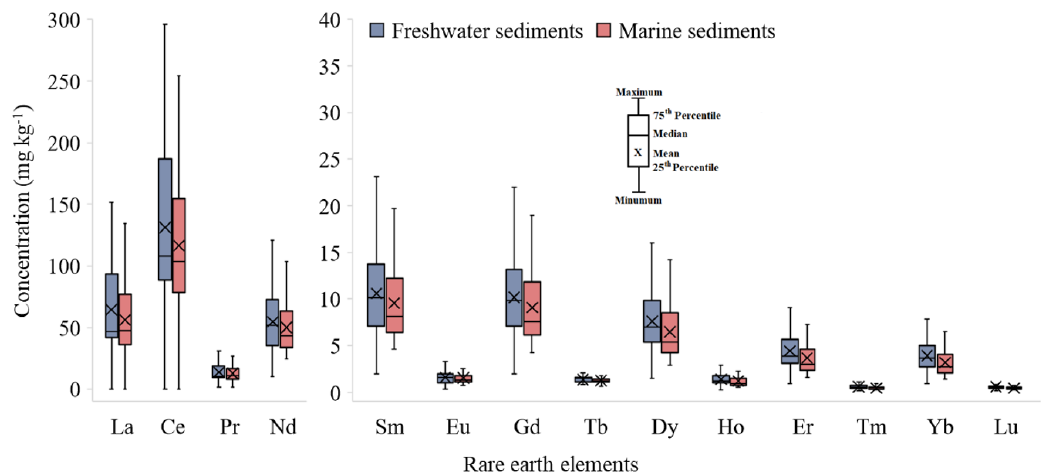
Figure 2. Box and whisker plot for the concentration (mg kg − 1 ) of the rare earth elements in freshwater and marine sediments.